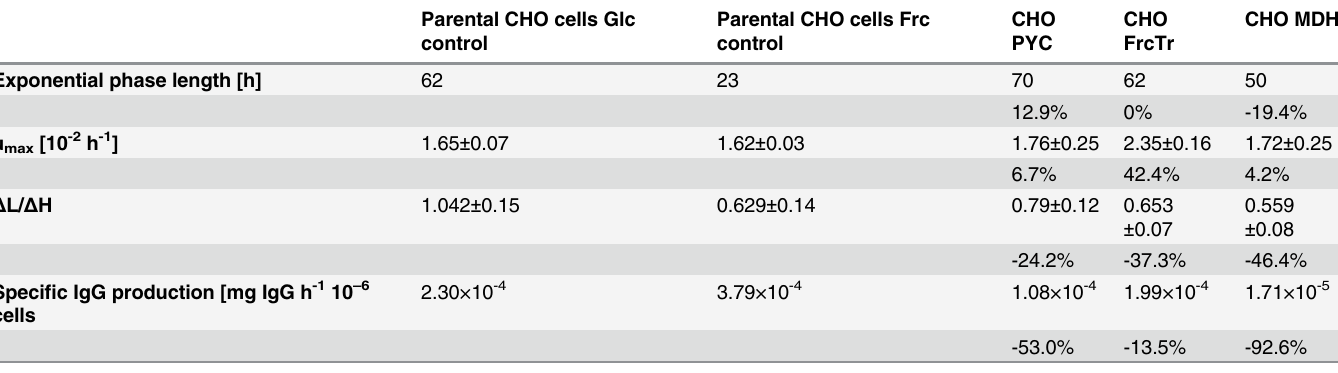
Table 1. Parameters for cell growth, Δ L/ Δ H a , IgG ’ s speci fi c productivity and their percentage variation vs. their respective control